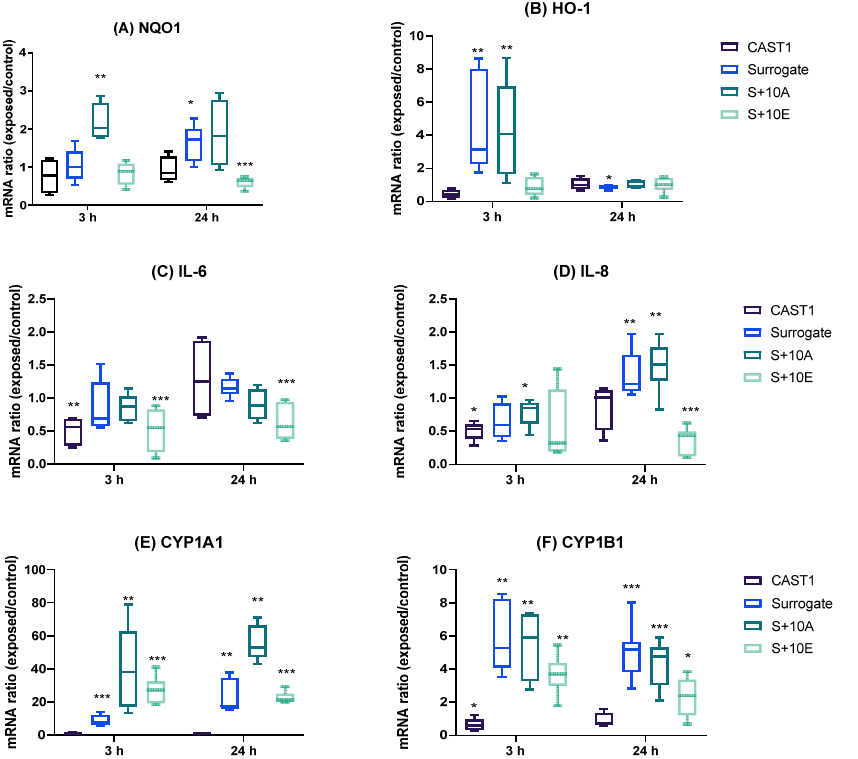
Figure 6. mRNA expression in ALI BEAS-2B cells after 3 h and 24 h exposure. ( A , B ): Oxidative stress markers NQO1 and HO-1 transcript production. ( C , D ): Inflammation markers IL-8 and IL-6 transcript production. ( E , F ) Xenobiotic metabolism markers CYP1A1 and CYP1B1 transcript production. Results are expressed as the median ± SD of at least four independent experiments. Statistical analysis was performed using the non-parametric Mann–Whitney U test (GraphPad for Windows, v9.4.0). Statistically significant differences were reported with * p < 0.05, ** p < 0.01, *** p < 0.001.